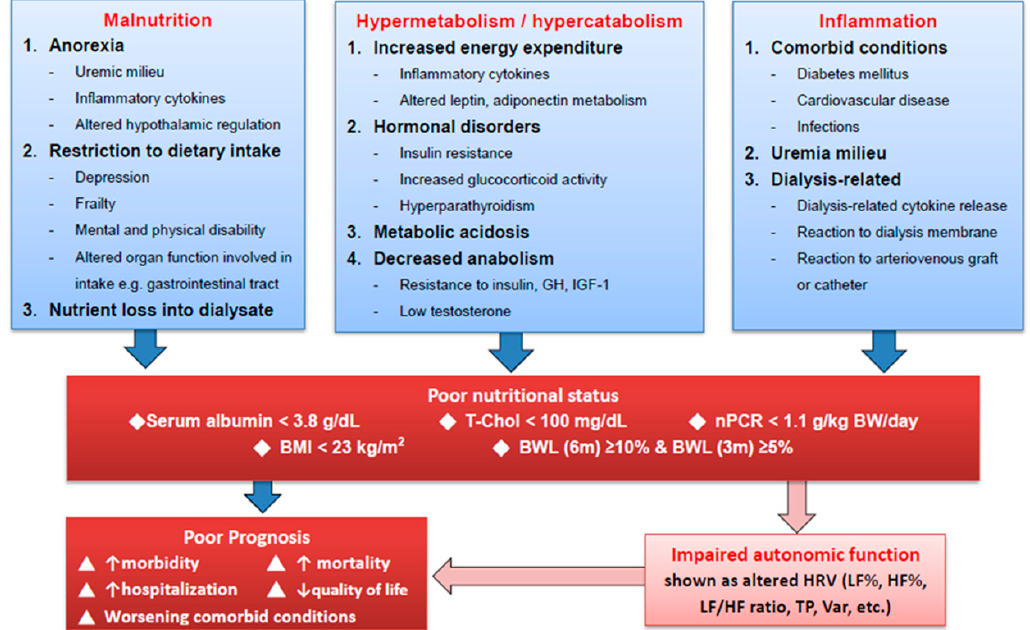
Figure 2. Proposed mechanism linking poor nutritional status to poor prognoses of hemodialysis patients. Abbreviations: BMI: Body mass index; BWL (6 m): Bodyweight loss within six months; BWL (3 m): Bodyweight loss within three months; GH: Growth hormone; HF%: Normalized high frequency; IGF-1: Insulin-like growth factor-1; LF%: Normalized low frequency; nPCR: Normalized protein catabolic rate; T-Chol: Total cholesterol; TP: Total power; Var: Variance of the R-R intervals.